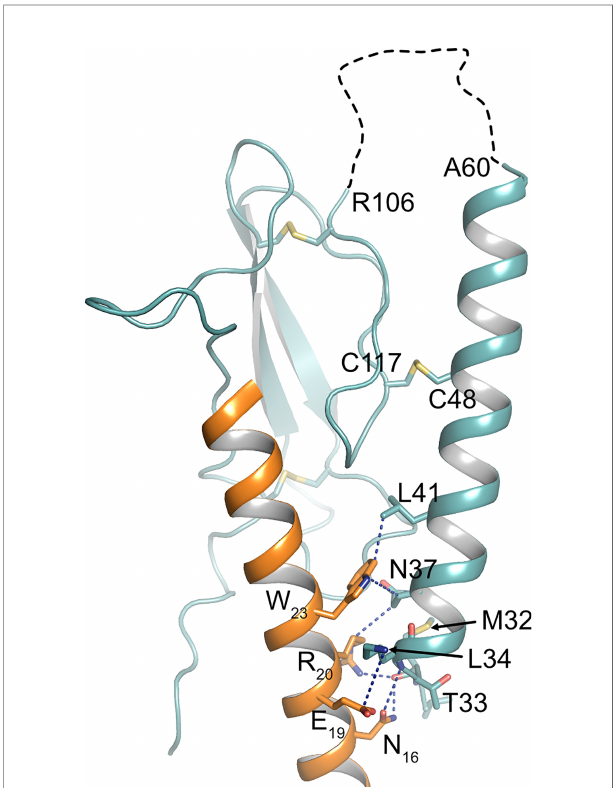
FIGURE 5 | Interface between PTH and a 1-helix of PTH1R ECD. Crystal structure of the PTH1R ECD (teal) in complex with PTH (orange) (PDB ID: 6FJ3). Residues forming the interface are shown as stick, and contacts are indicated as blue dashed lines. The unstructured loop 1 of the ECD is shown as black dashed